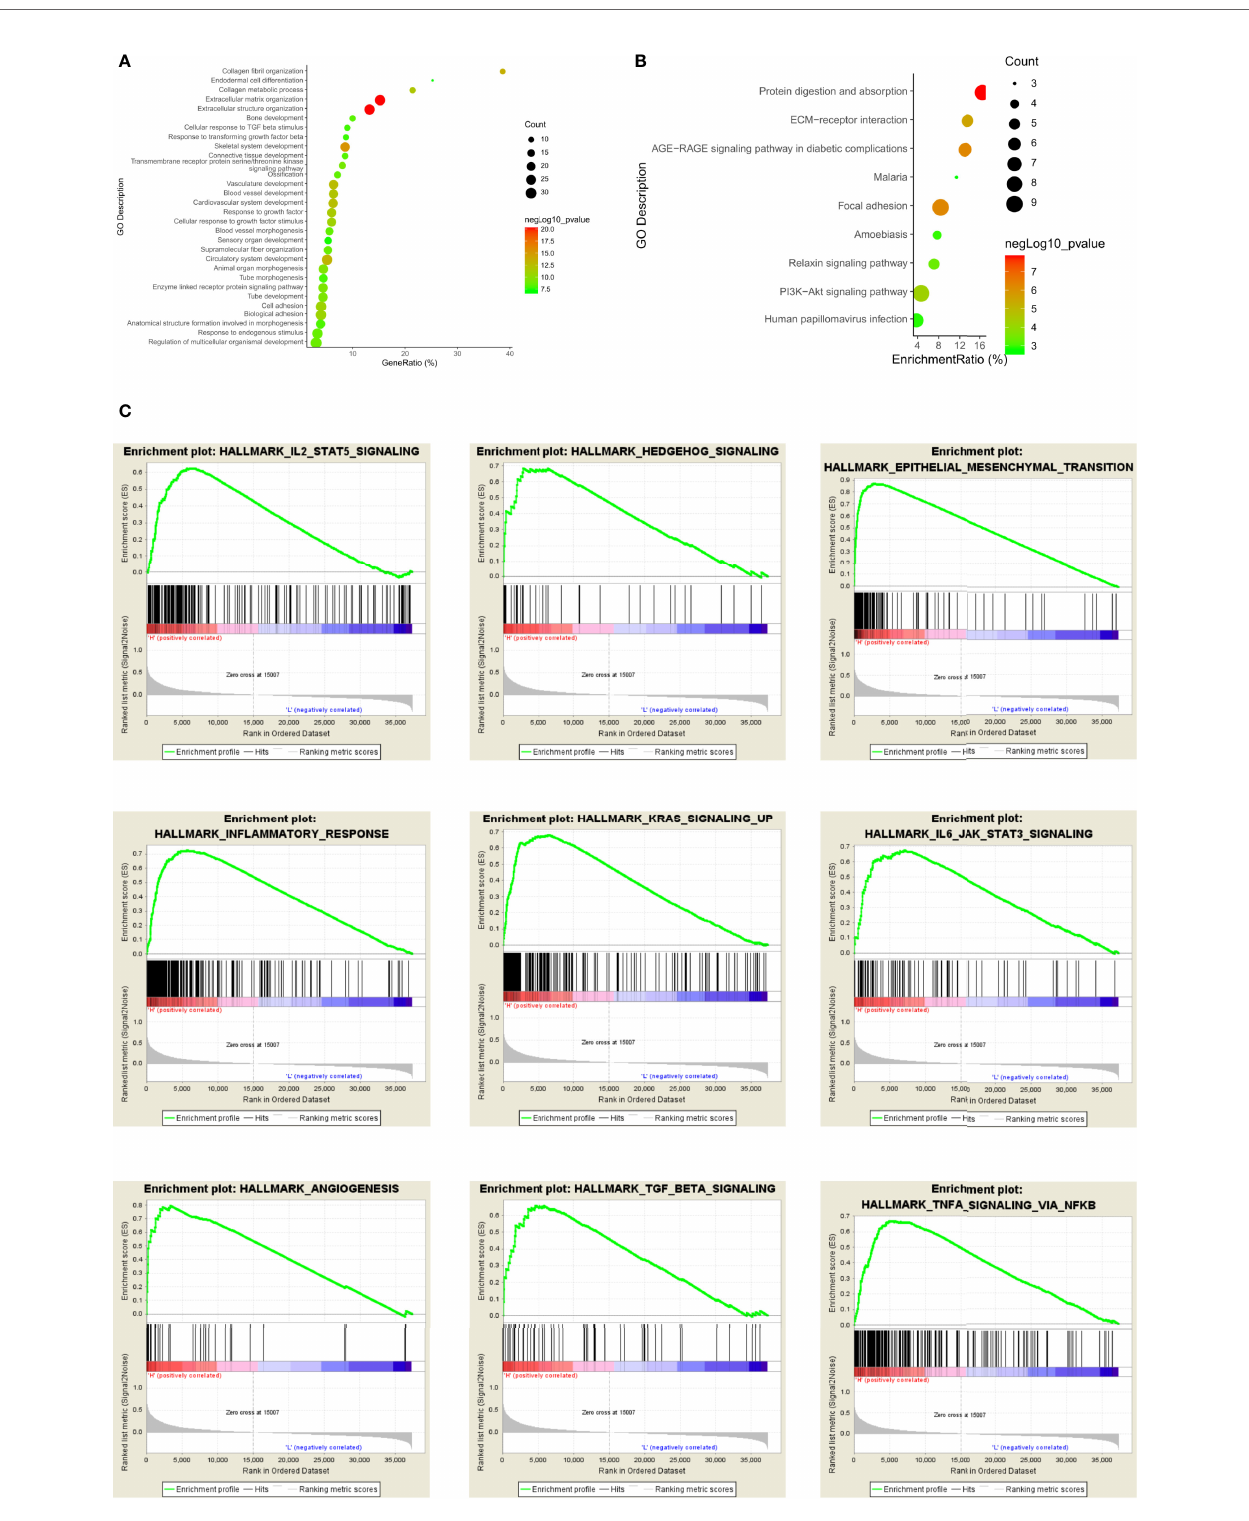
FIGURE 10 | Functional enrichment analysis of GPX8 in stomach adenocarcinoma. (A) GO analysis of GPX8 in stomach adenocarcinoma. (B) KEGG signaling pathway of GPX8 in stomach adenocarcinoma. (C) GSEA analysis of GPX8 in stomach